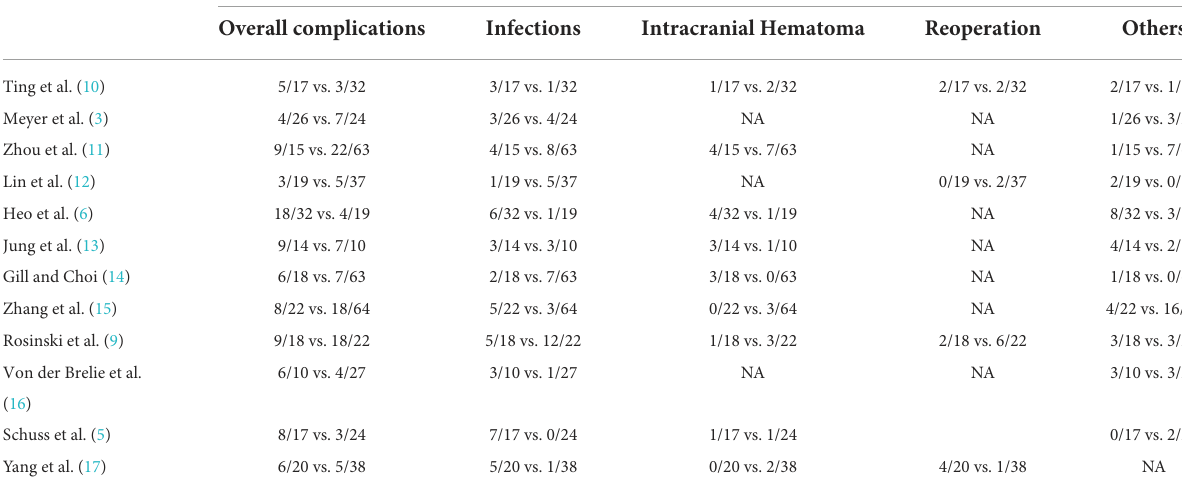
TABLE 2 Summary of postoperative complications in different studies (simultaneous operation vs. staged